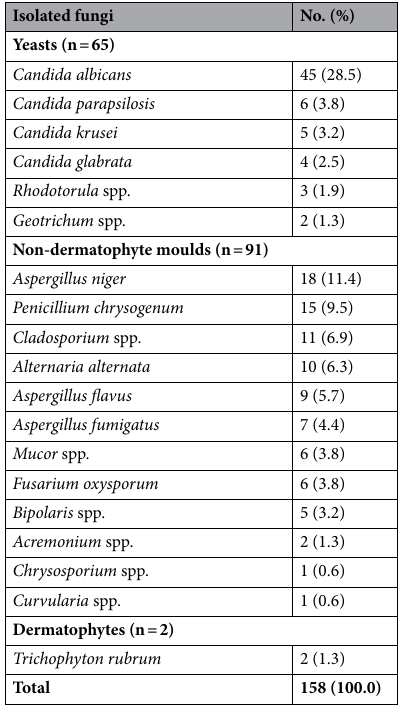
Table 5. Isolated fungi from 158 students with fungal contamination of their mobile